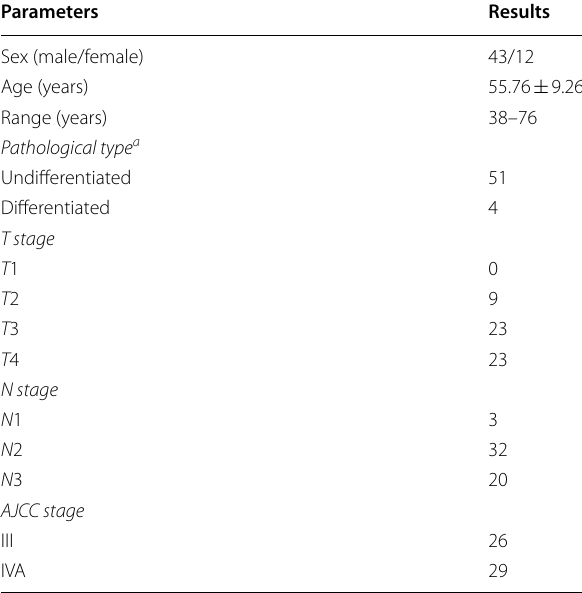
Table 1 Clinical data of patients with